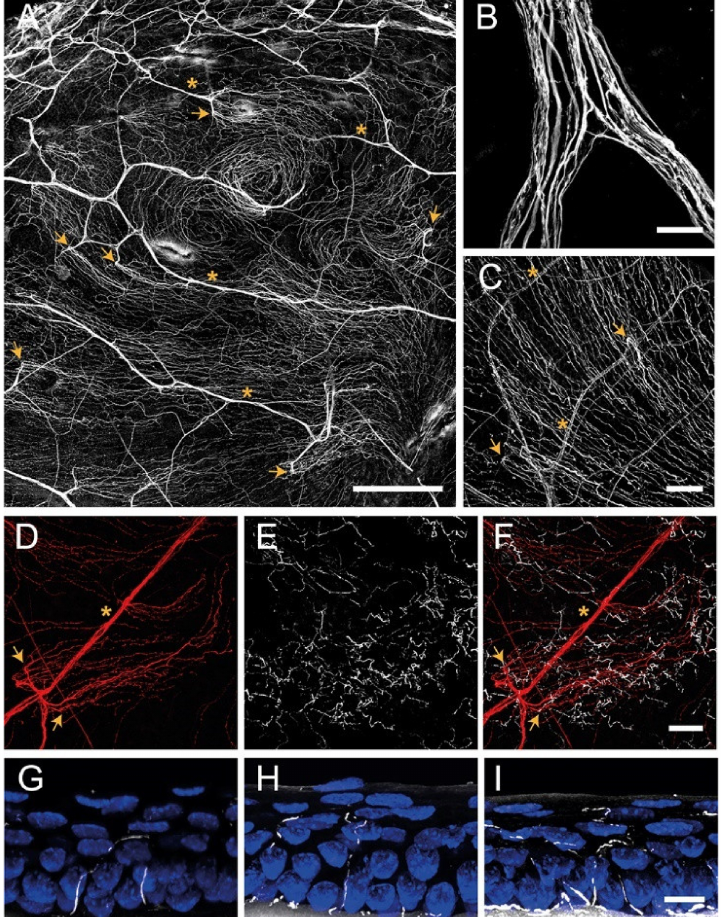
Figure 2. Confocal images of sensory nerves immunostained with anti– β tubulin III antibody in mouse cornea. ( A ) Sensory nerve trunks enter from the limbus into the stroma of the cornea where they ramify, giving rise to a dense subepithelial plexus (asterisks). ( B ) Detail of a stromal nerve trunk branching. ( C , D ) From the stroma, nerve fibers penetrate through the basal lamina (arrowheads) and form the subbasal plexus. Subbasal nerve fibers run parallel for a long distance within the epithelium basal cell layer. ( E – I ) Subbasal nerves give rise to terminal branches that ascend along their trajectory through the epithelial cells. According to the number of branches, three morphological types of corneal nerve terminals are identified: simple ( G ), ramified ( H ), and complex ( I ) nerve terminals. Scale bars: ( A ) 250 µ m; ( B ) 25 µ m; ( C – F ) 50 µ m; ( G – I ) 10 µ m. Methods: C57BL/6J eyes were fixed for 2 h at RT in methanol and DMSO (4:1), incubated 5 min at − 20 ◦ C in methanol, rehydrated, and washed in PBS. ( A – F ) Corneas were dissected, incubated 2 h at RT in blocking solution (5% goat normal serum, 1% BSA and 0.1%Triton X–100 in PBS) and 48 h at 4 ◦ C with anti– β tubulin III